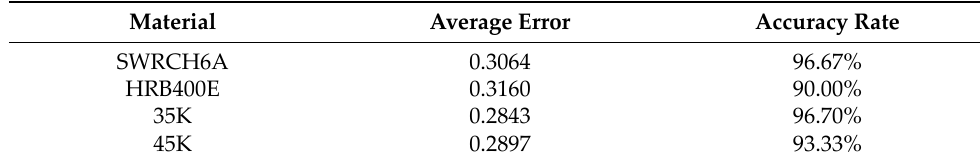
Table 1. Detection Results of Various Types of Steel.